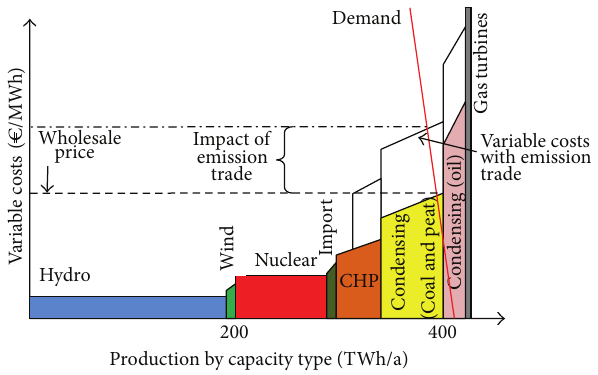
Figure 1: Production structure of Nordic power market.